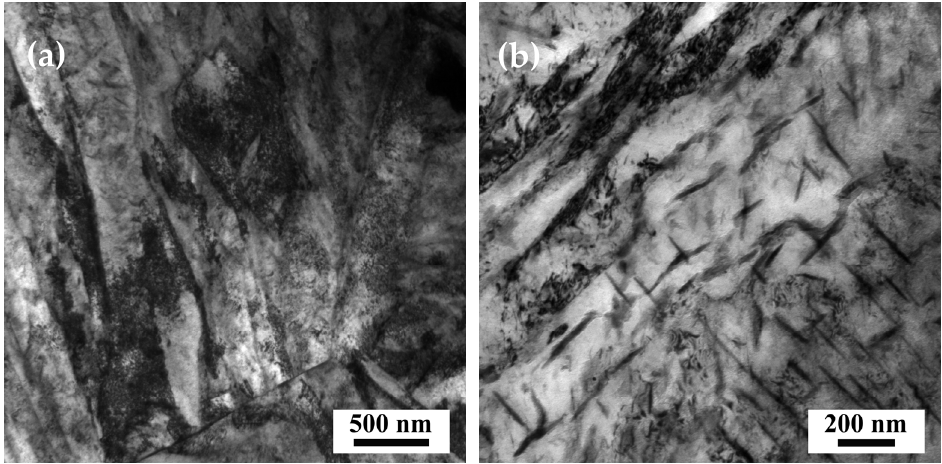
Figure 8. Transmission electron microscopy images of the NM450 steel plate. ( a ) Lath martensite and ( b ) nanoscale carbide precipitates.